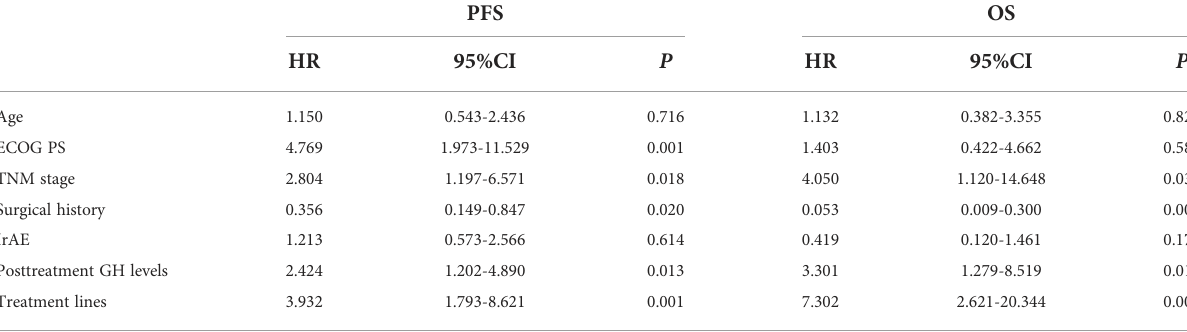
TABLE 4 Multivariate analyses of progression-free survival and overall survival with the Cox proportional hazards model.